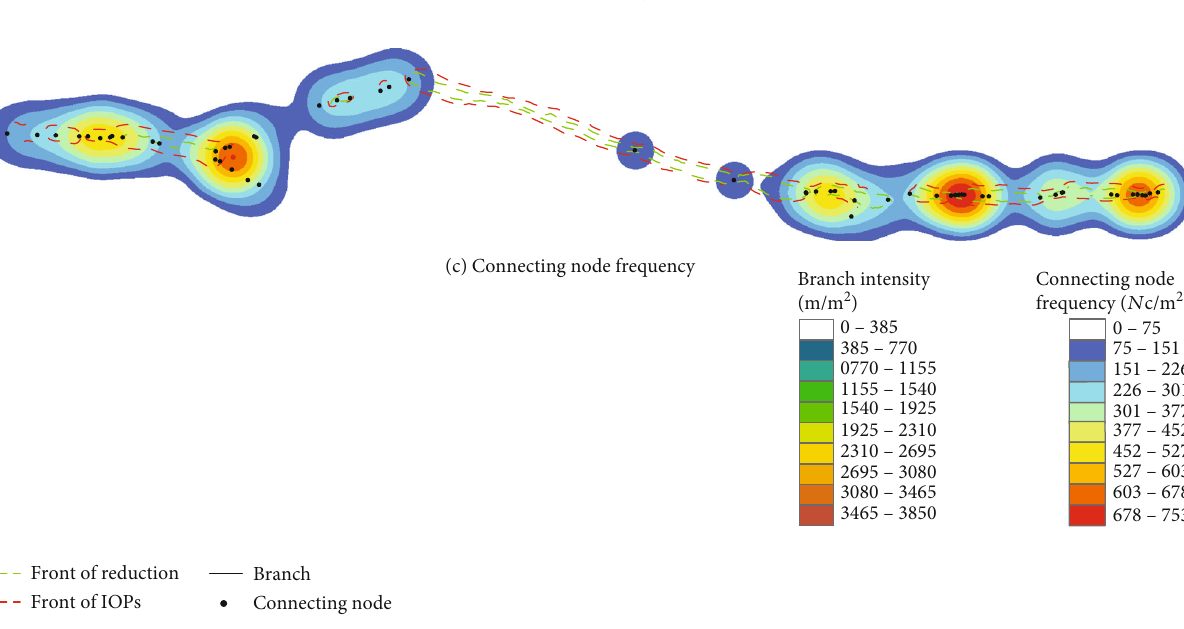
Figure 11: (a) Digitized map of a fracture network at Marsalforn, Malta, with iron oxide precipitates shown as red dashed lines and a front of bleaching shown with a green dashed line. (b) Branch intensity map indicating higher density in complex zones. (c) Connecting node frequency map of the locality. There is no obvious correlation between iron oxide precipitates and higher branch intensity/connecting node frequency in this example; the iron oxide precipitates are rather localized along the pull-apart